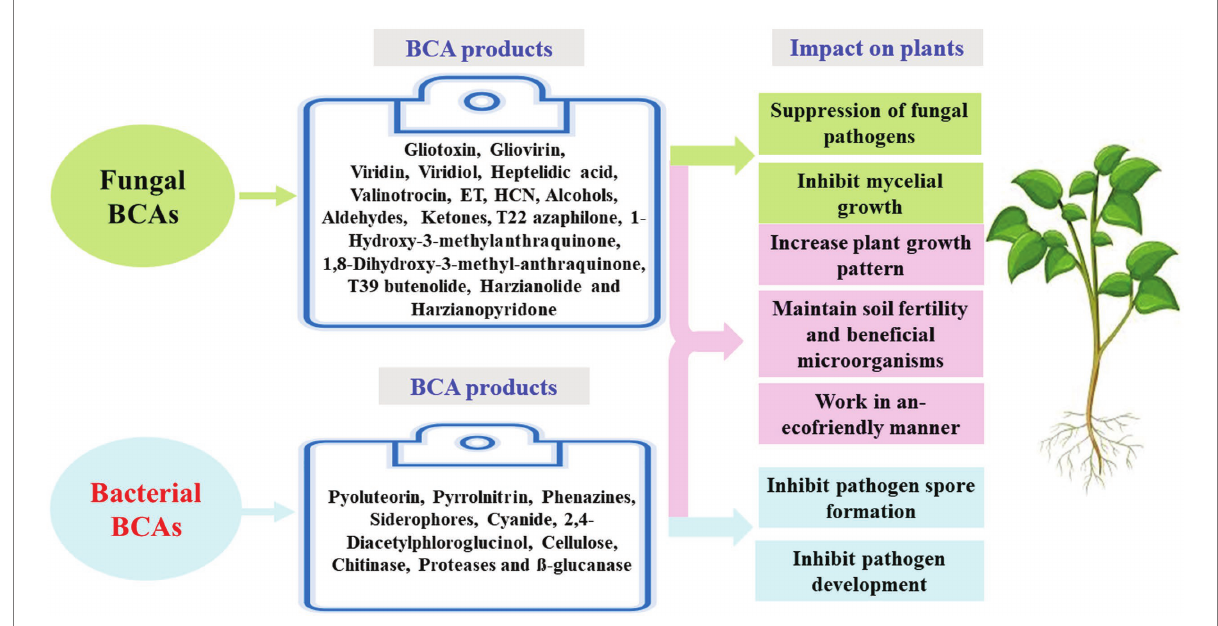
FIGURE 2 Fungal and bacterial biocontrol agents (BCAs) and their impact on plant. ET, ethylene; HCN, hydrogen